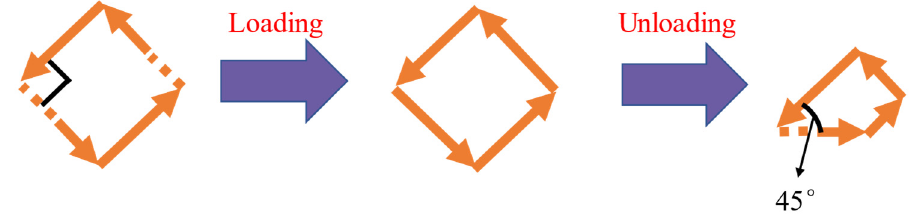
Figure 3. Schematic diagram of vortex variation.